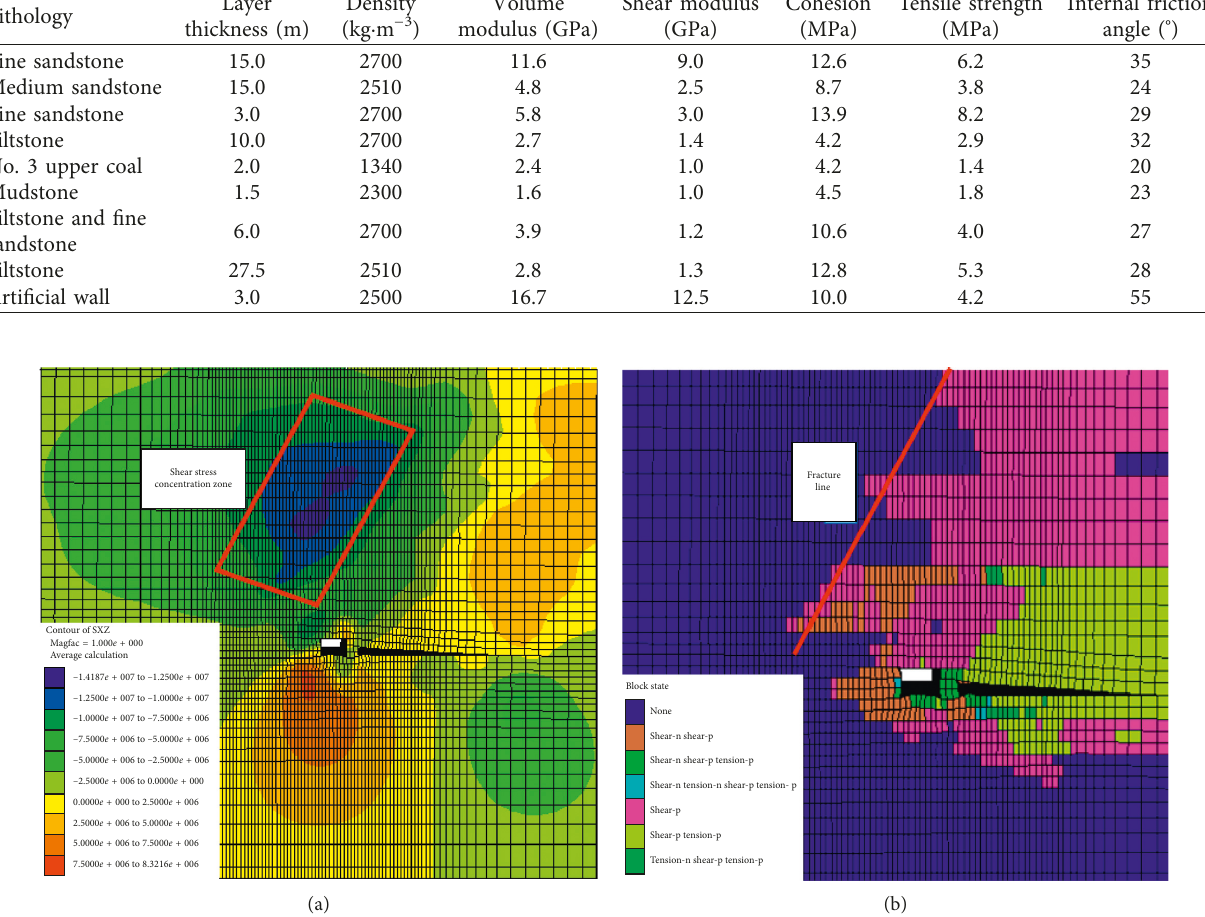
Figure 3: Gob-side entry retaining surrounding rock characteristics: (a) distribution characteristic of shear stress; (b) distribution characteristics of the elastic and plastic